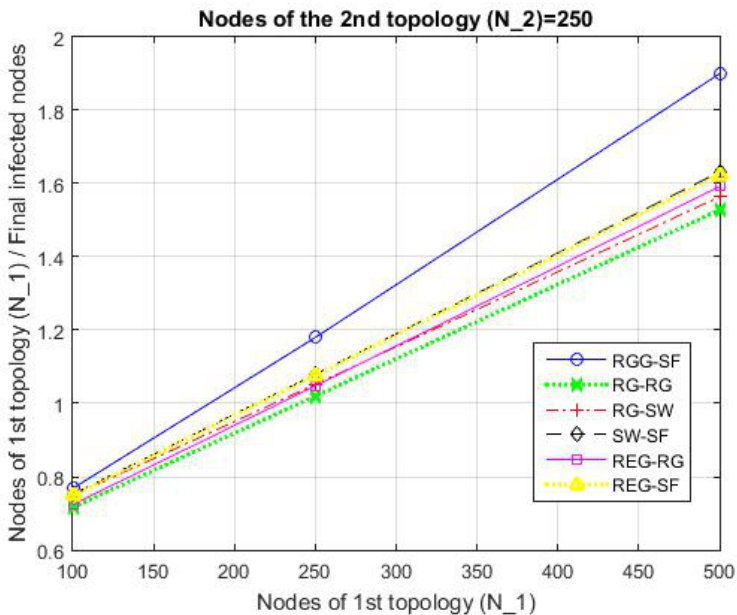
Figure 12. Spread of malware while the nodes of the 2nd topology remain equal to N_1 =